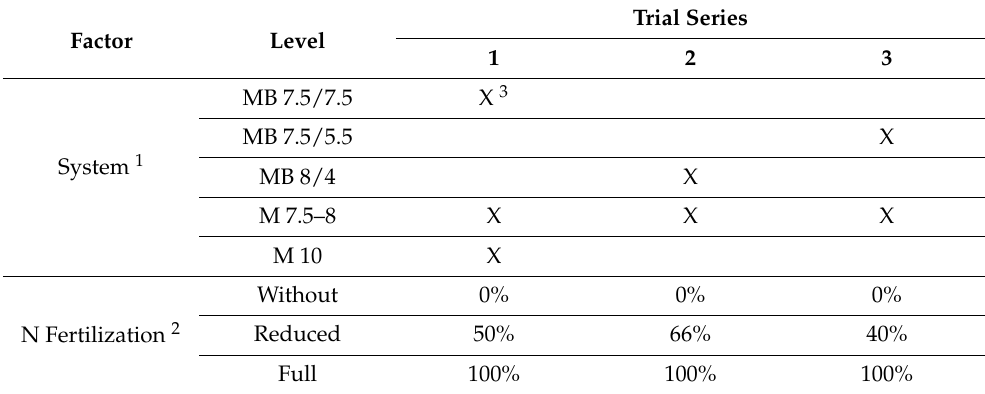
Table 2. Factor levels of the field trials.